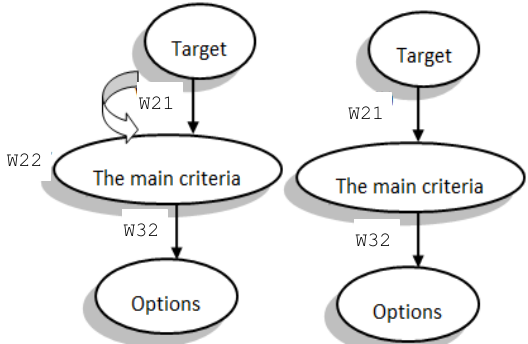
Fig. 2. Form of conceptual research model with AHP and ANP approach, source